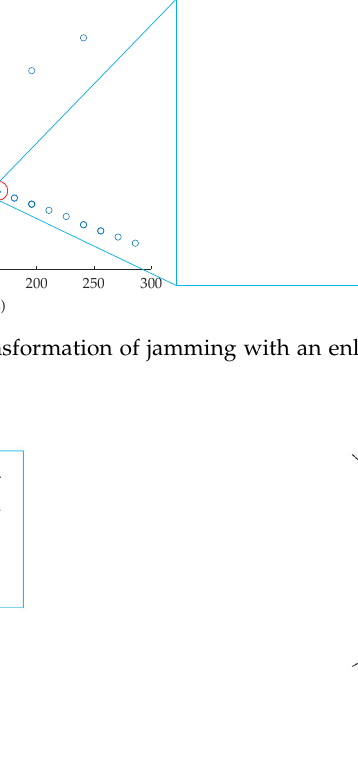
Figure 5. The moving target track detected by ground-based radar in polar coordinates: ( a ) before interpolation; ( b ) after interpolation.